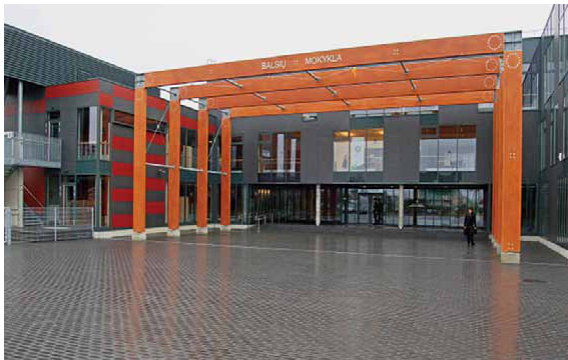
courtyardfig. 5. The realization of the partnership project on the school in Balsiai at the local authority level: the main